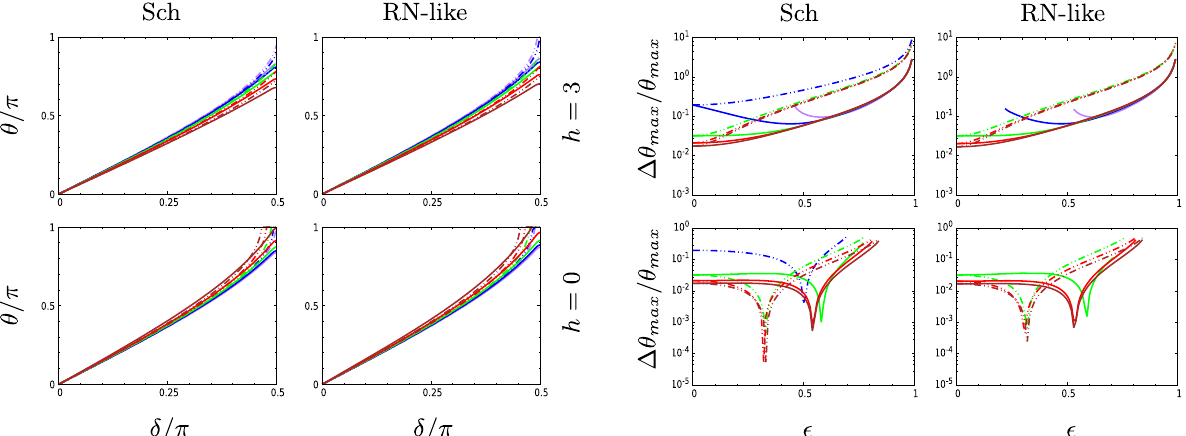
Fig. 13 Relative error in θ max ( | θ max , a − θ max | /θ max ) as a function of (cid:11) for r = R . q ∗ = − ( 0 . 50 M ) 2 . The purple, blue, green, red and brown linescorrespondrespectivelyto R = 3 . 5,4,5,6and7.Continuouslines were obtained from Eq. (5.2) (with plasma correction) while dashed lines from Eq. (5.1) (without plasma correction)